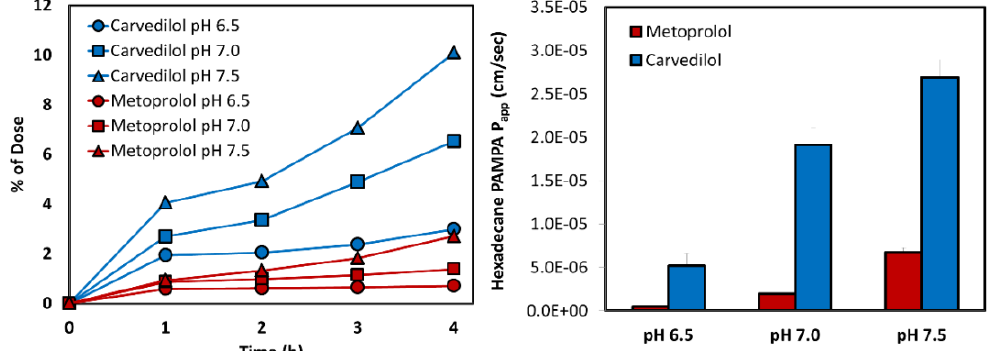
Figure 4. The hexadecane-based parallel artificial membrane permeability assay (PAMPA) permeability studies for carvedilol vs. metoprolol in the different pH conditions along the small intestine: amounts transported (mmol) as a function of time (left panel), and the corresponding P app values (right panel; cm/s). Mean ± SD; n = 4.